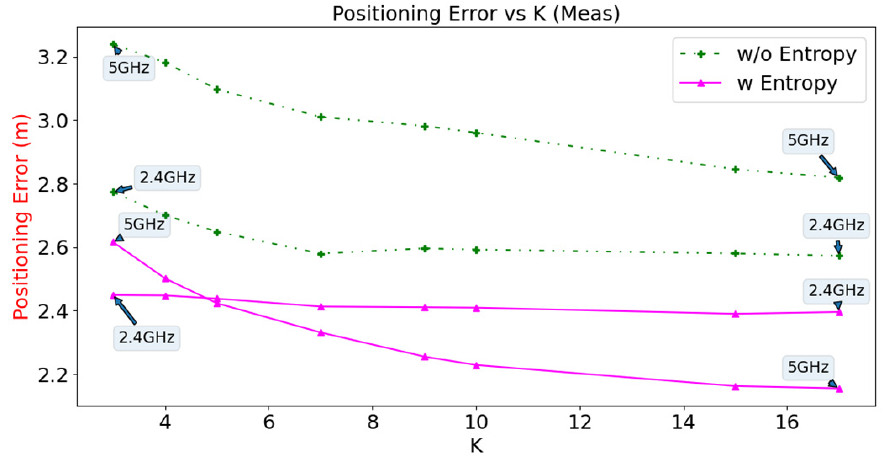
Figure 15. Positioning error versus the value of K for measured data.